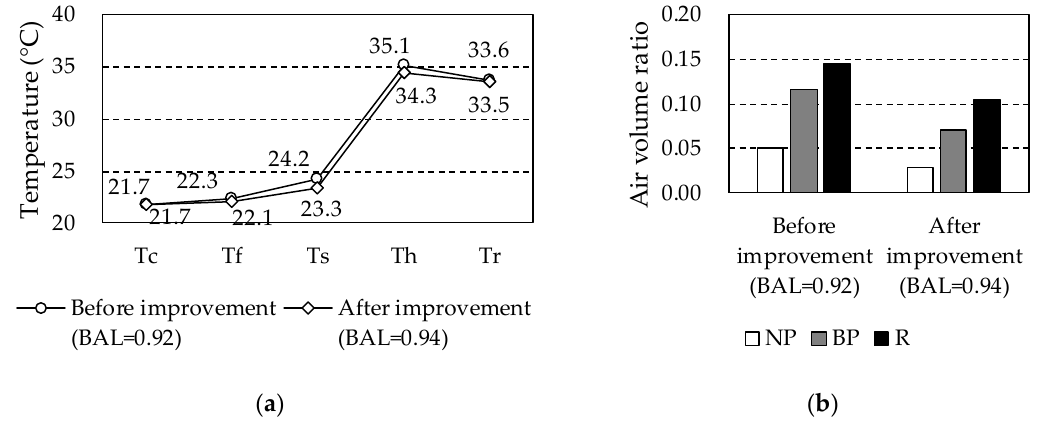
Figure 9. Improvement effect of thermal environment at CRAC fan frequency of 54 Hz: ( a ) average temperature of each part and ( b ) air-management metrics.